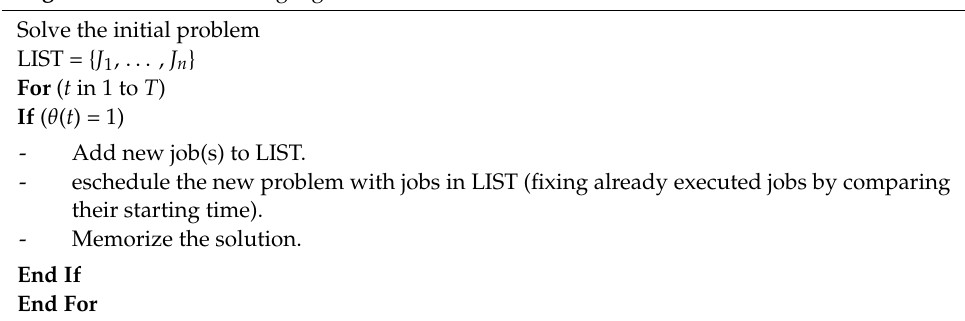
Algorithm 1. Rescheduling